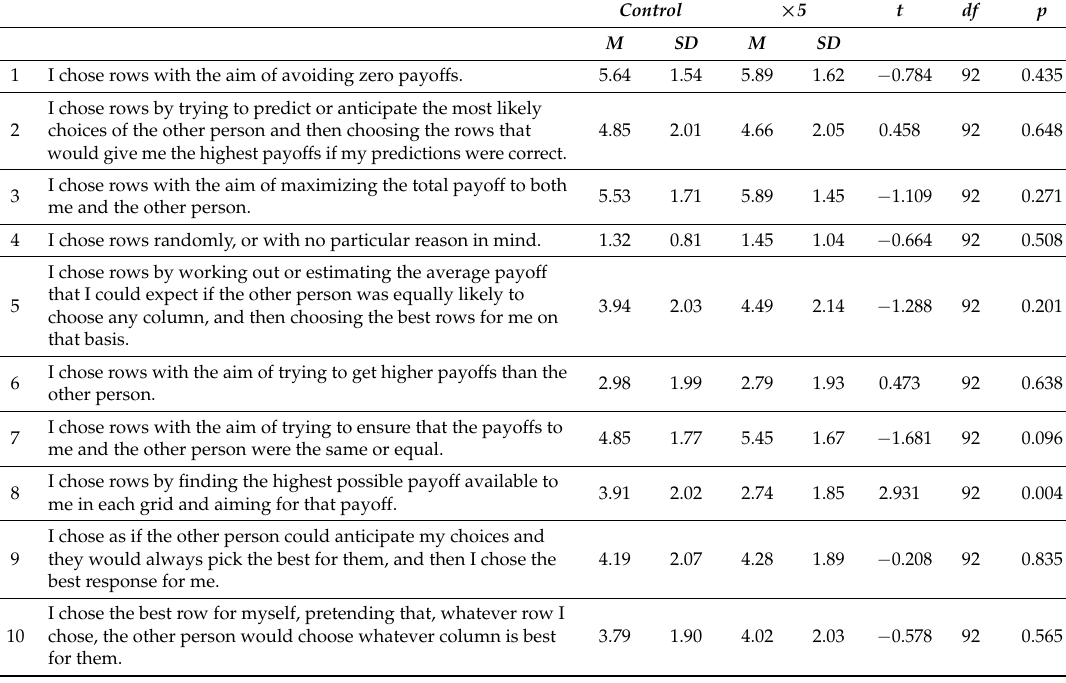
Table 1. Self-reported reasons for strategy choices, with mean ratings of the extent to which each reason influenced players’ choices, ranging from 1 ( Strongly disagree ) to 7 ( Strongly agree ), and associated standard deviations ( N = 47) and t tests, for both conditions (control and × 5 experimental). Control × 5 t df p M SD M